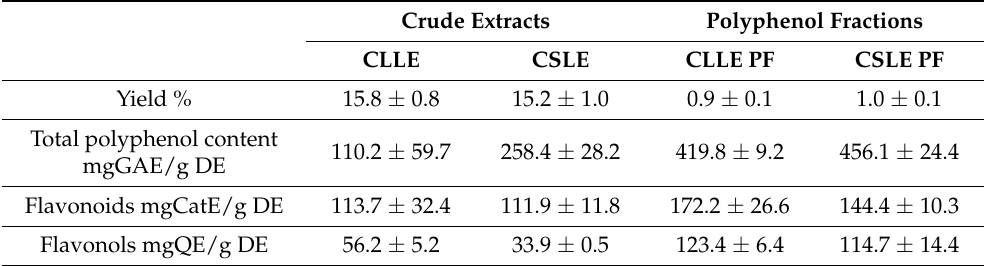
Table 1. Phytochemical analysis and yield extraction of C. laurifolius L. and C. salviifolius L. crude extracts and their polyphenol